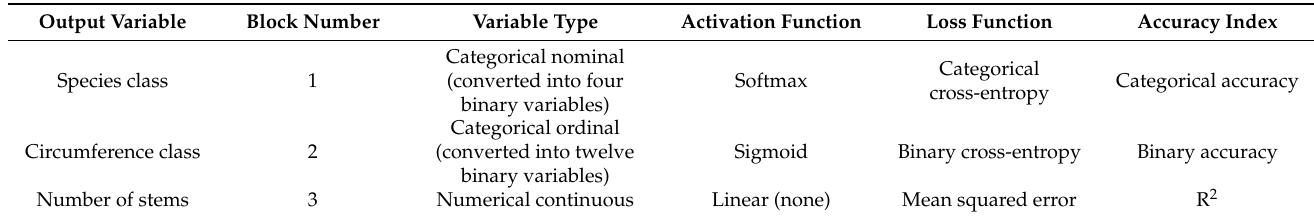
Table 4. NN architecture for the three